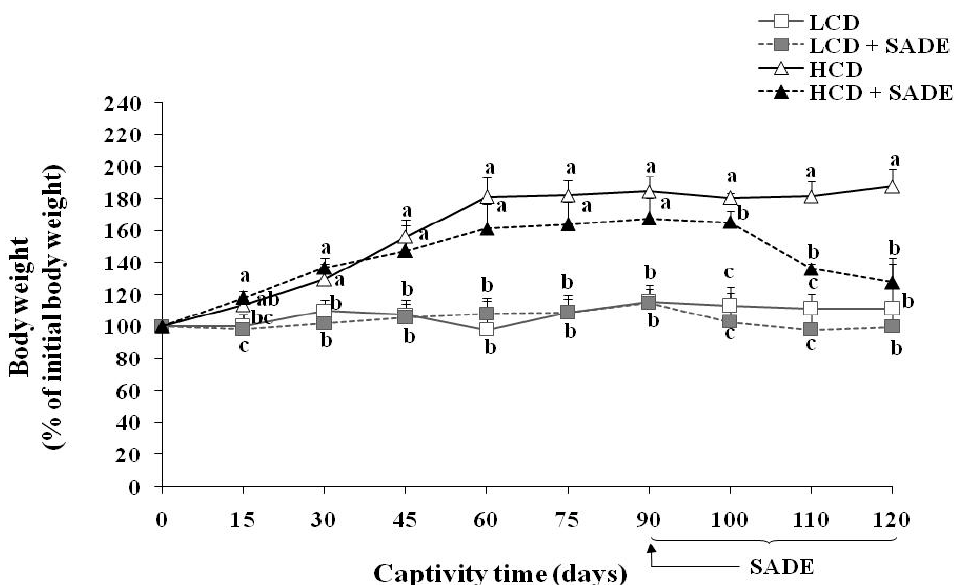
Figure 2. Body weight in % of initial weight in LCD: low-calorie diet, LCD + SADE: animals group treated with S. arabica decocted, HCD: rats fed with high-calorie diet and HCD + SADE: rats fed with high-calorie diet treated with S. arabica decocted extract. Results are presented as means ± SD for ten rats in each group. Means not sharing the same superscript letters (a, b, c) for each captivity time are significantly different between groups (Tukey’s post hoc test, p < 0.05). “a” denotes the highest value and “c” represents the lowest value.